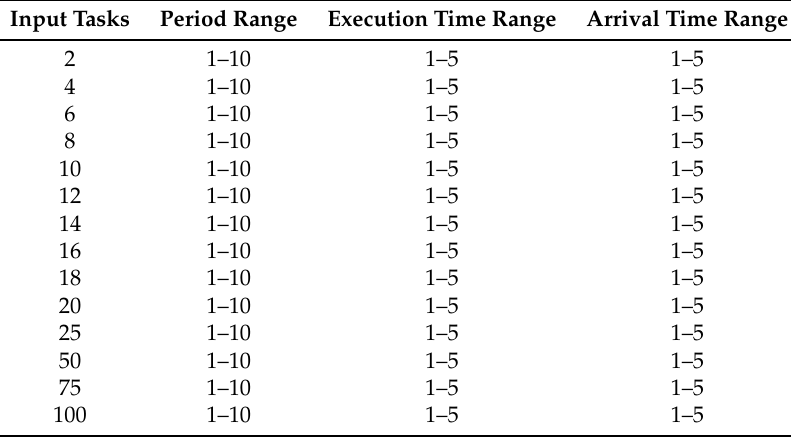
Table 4. Scenario: Varying number of input tasks.